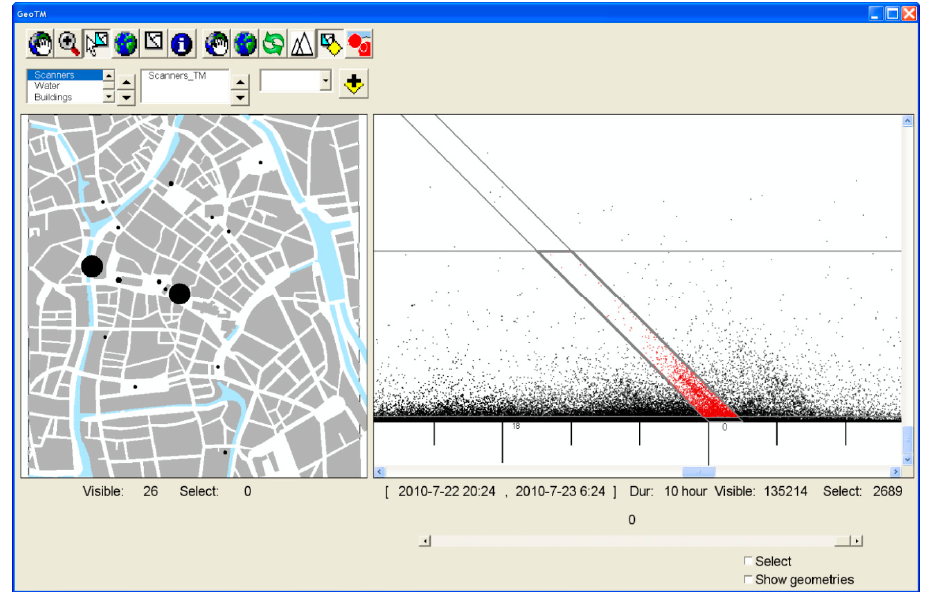
Figure 5. The interface of the GeoTM with a map view in the left and TM view in the right, which are dynamically linked. Temporal queries can be performed by creating geometric zones in the TM (adapted from [14]).